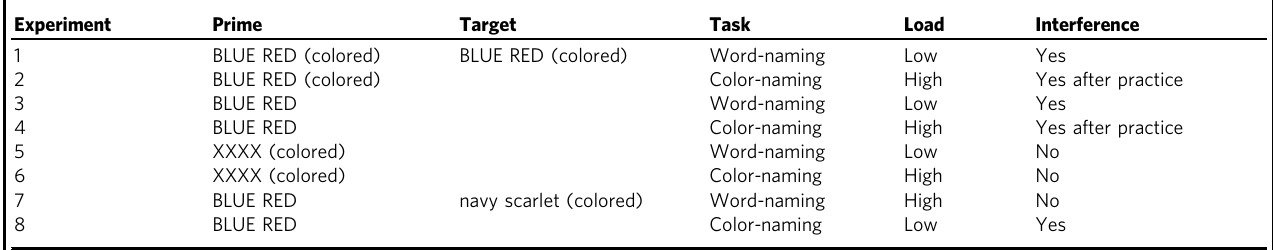
Table 2 Conditions, manipulations, and effects in all